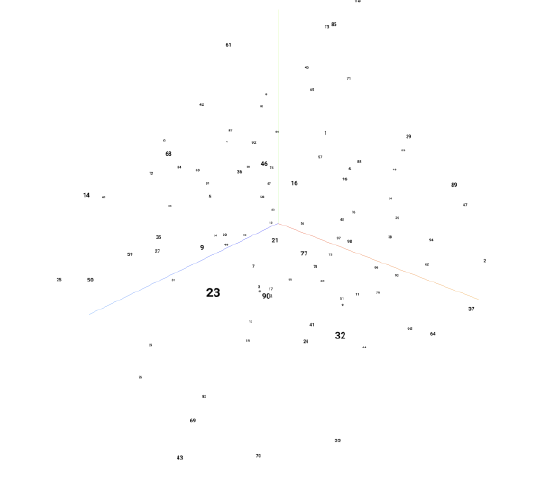
Figure 5. The demonstration of the PCA 1-2-3 result.